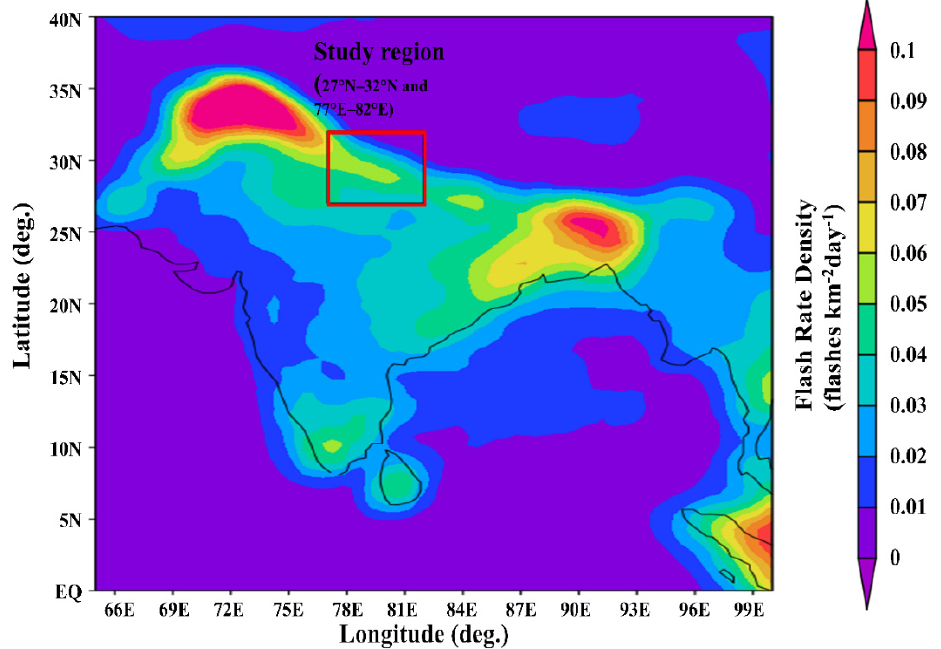
Figure 1. Mean lightning flash rate density for the period of 2000–2013 from combined lightning imaging sensor (LIS) and optical transient detector (OTD)